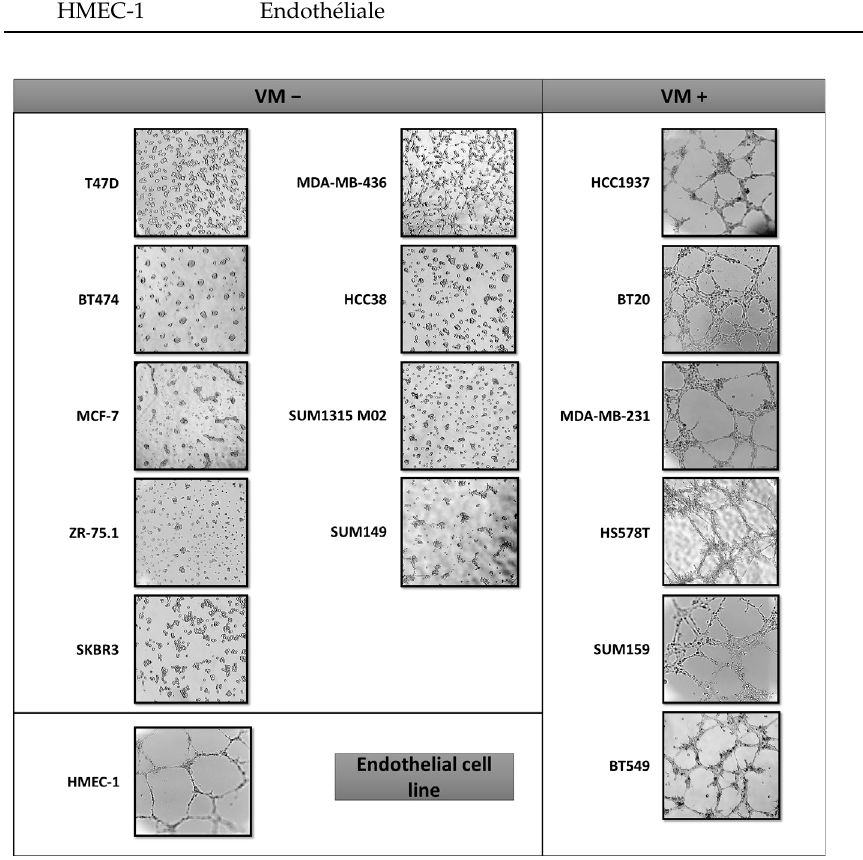
Figure 1. Vascular mimicry ability on the breast cancer cell lines subtypes. Phase contrast images show the vascular channel formation. Images were captured 24 h after plating on Matrigel. Experiments were realized at least 3